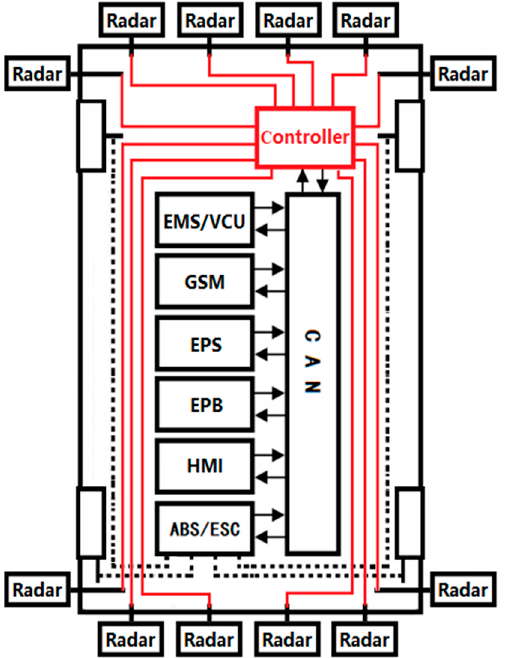
Figure 20. Framework of Automatic Parking System.